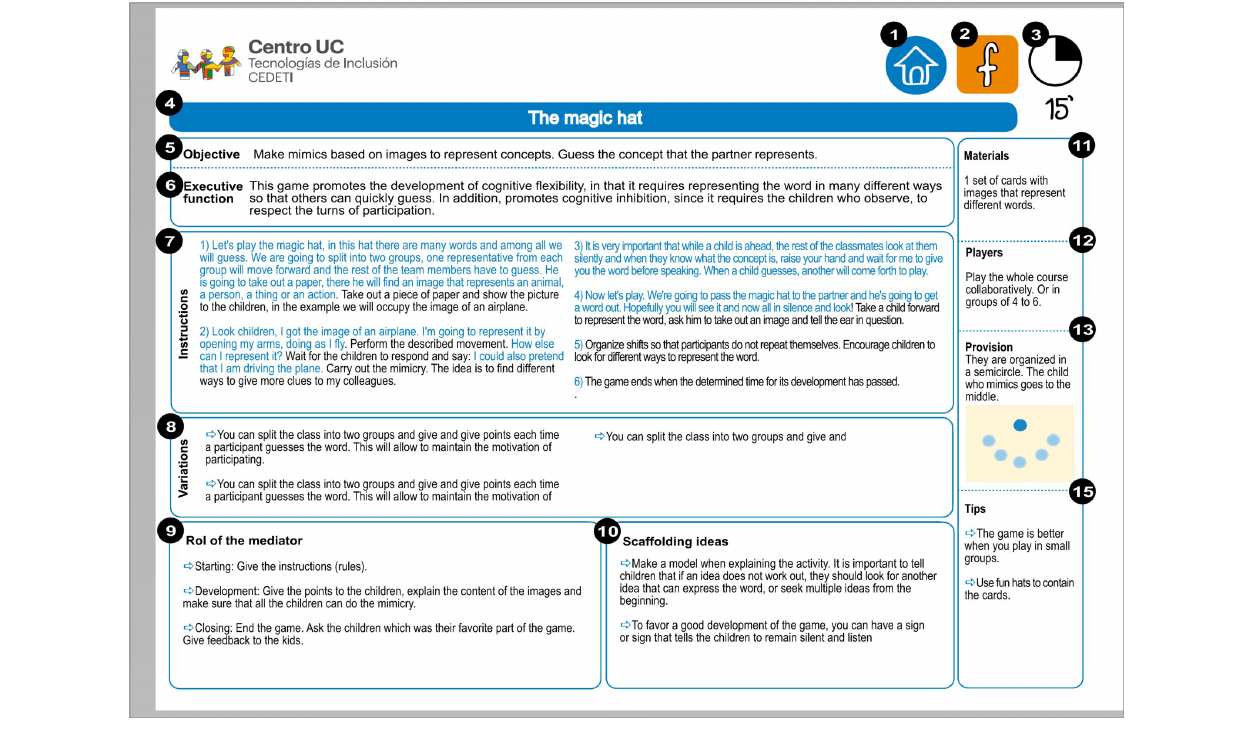
Frontiers in Psychology |